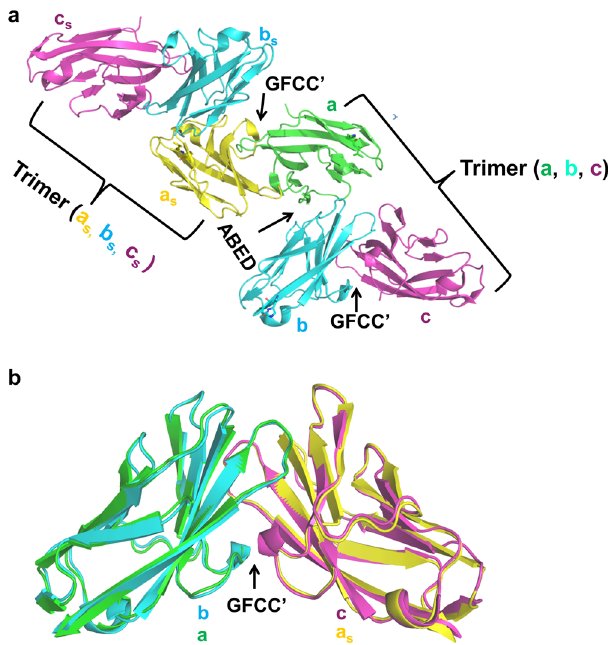
Fig. 4 Human CEACAM1 higher-order oligomer formation is mediated by GFCC ’ face interactions between two oligomers. a Human CEACAM1 higher-order oligomer formed by GFCC ’ face-mediated interactions between two hCEACAM1 oligomers as observed in the crystal structure. Human CEACAM1 oligomers present in the crystal asymmetric unit and symmetry-related oligomer are shown, wherein molecules a, b and c and its symmetry mates labeled a s (yellow), b s (cyan) c s (magenta) are shown by ribbon diagram. Central to higher-order oligomer formation is GFCC ’ face- mediated interactions between molecules a (green) from the fi rst trimer (formed by molecules a, b and c) and its symmetry-mate a s (yellow) from the second trimer (formed by molecules a s , b s , and c s ). b Superimposition of the GFCC ’ -face mediated dimer present in both oligomers revealed similar GFCC-face mediated interactions, wherein GFCC ’ face dimers formed by molecules b and c, and by molecules a and it ’ s symmetry-mate a s are shown by ribbon diagram.